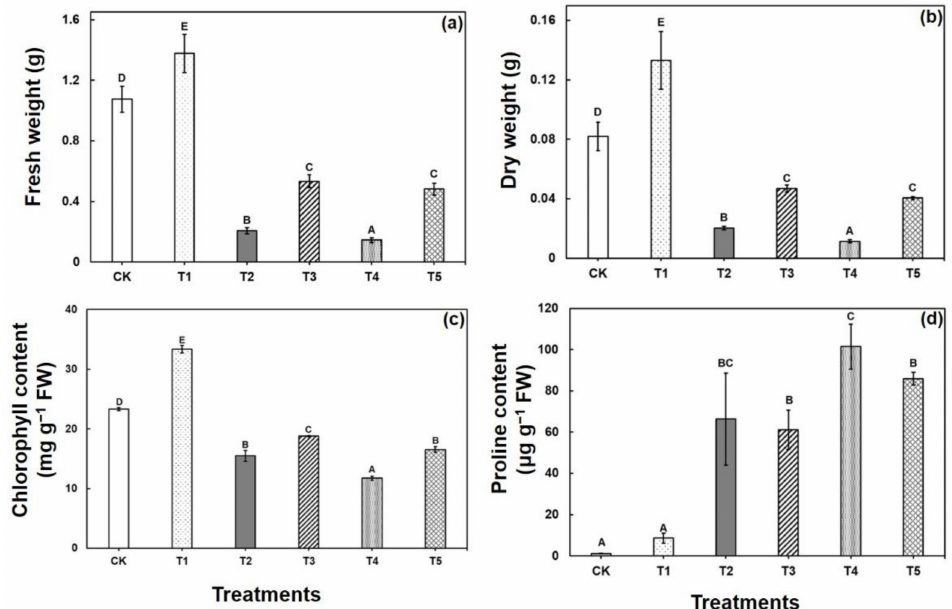
Figure 1. Effect of exogenous Cu and CA on fresh weight ( a ), dry weight ( b ), total chlorophyll (Chl) content ( c ), and proline (Pro) content ( d ) in Brassica seedlings with 0, 25, and 50 µ M and 0 or 1.0 mM CA. Each value represents the mean of three replicates ± SE. Different letters indicate significant differences at p < 0.05 among treatments by Tukey’s test. The treatments CK, T1, T2, T3, T4, and T5 represent control, CA, Cu25 µ M, CA + Cu25 µ M, Cu50 µ M, and CA + Cu50 µ M